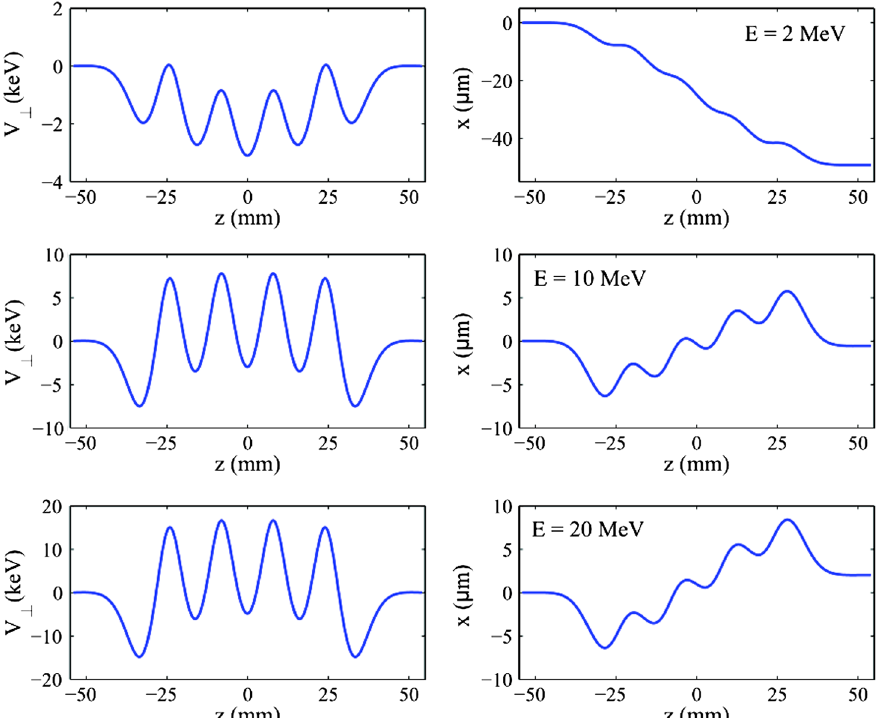
FIG. 2. Transverse momentum and the transverse offset as a function of distance in the deflector cavity for the reference particle at zero-crossing. The deflector cavity strength at 2, 10 and 20 MeV corresponds to a V max ⊥ ¼ 0 . 07 , 0.35 and 0.7 MeV, respectively. The final offset of the beam at the exit of the cavity is optimized for 10 MeV. If the beam energy is increased/decreased the final transverse offset shifts to positive/negative